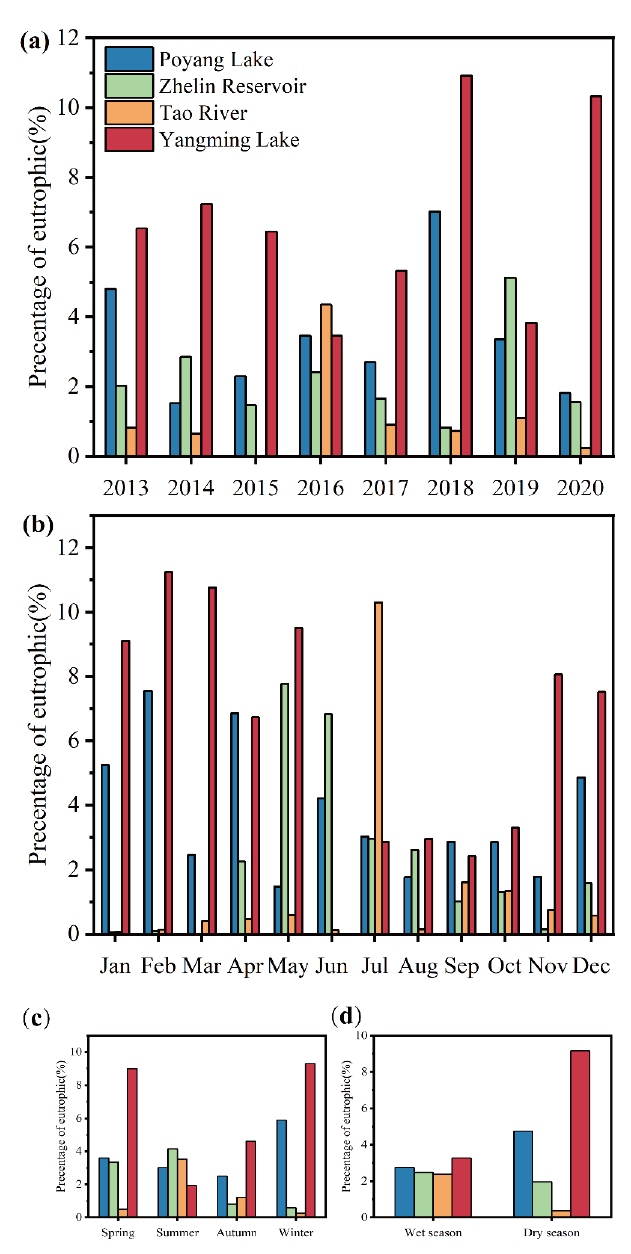
Figure 9. Spatial patterns of eutrophic water body proportion in four typical regions: ( a ) Annual distribution, ( b ) Monthly distribution, ( c ) Quarterly distribution, and ( d ) Pattern distribution between wet and dry seasons.